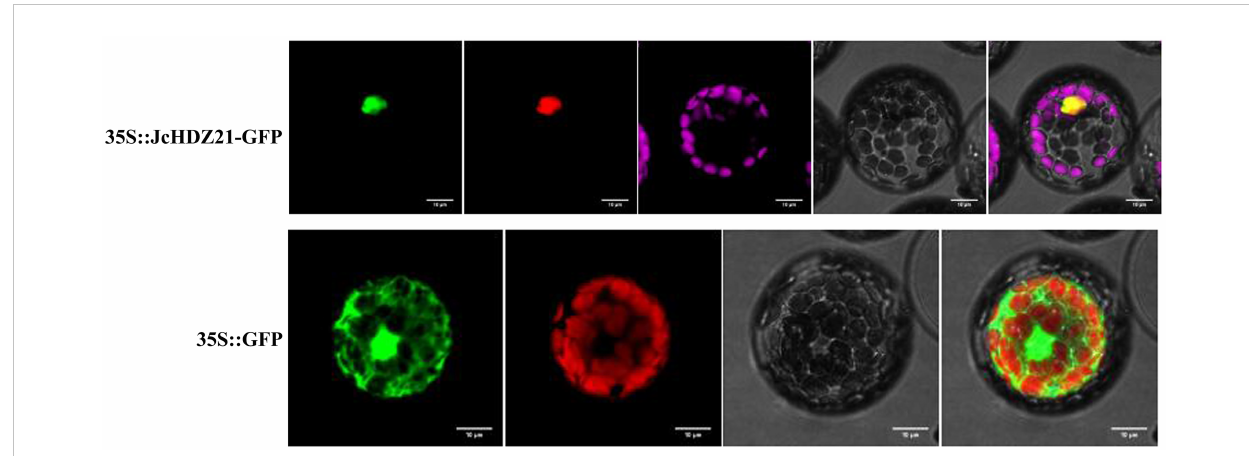
FIGURE 3 Subcellular localization of JcHDZ21 protein. 35S::JcHDZ21-GFP shows GFP, NLS-Cherry, Chlorophy II, Bright and Merge from left to right, whereas 35S::GFP shows GFP, Chlorophy II, Bright and Merge from left to right. Bars shows 10 m